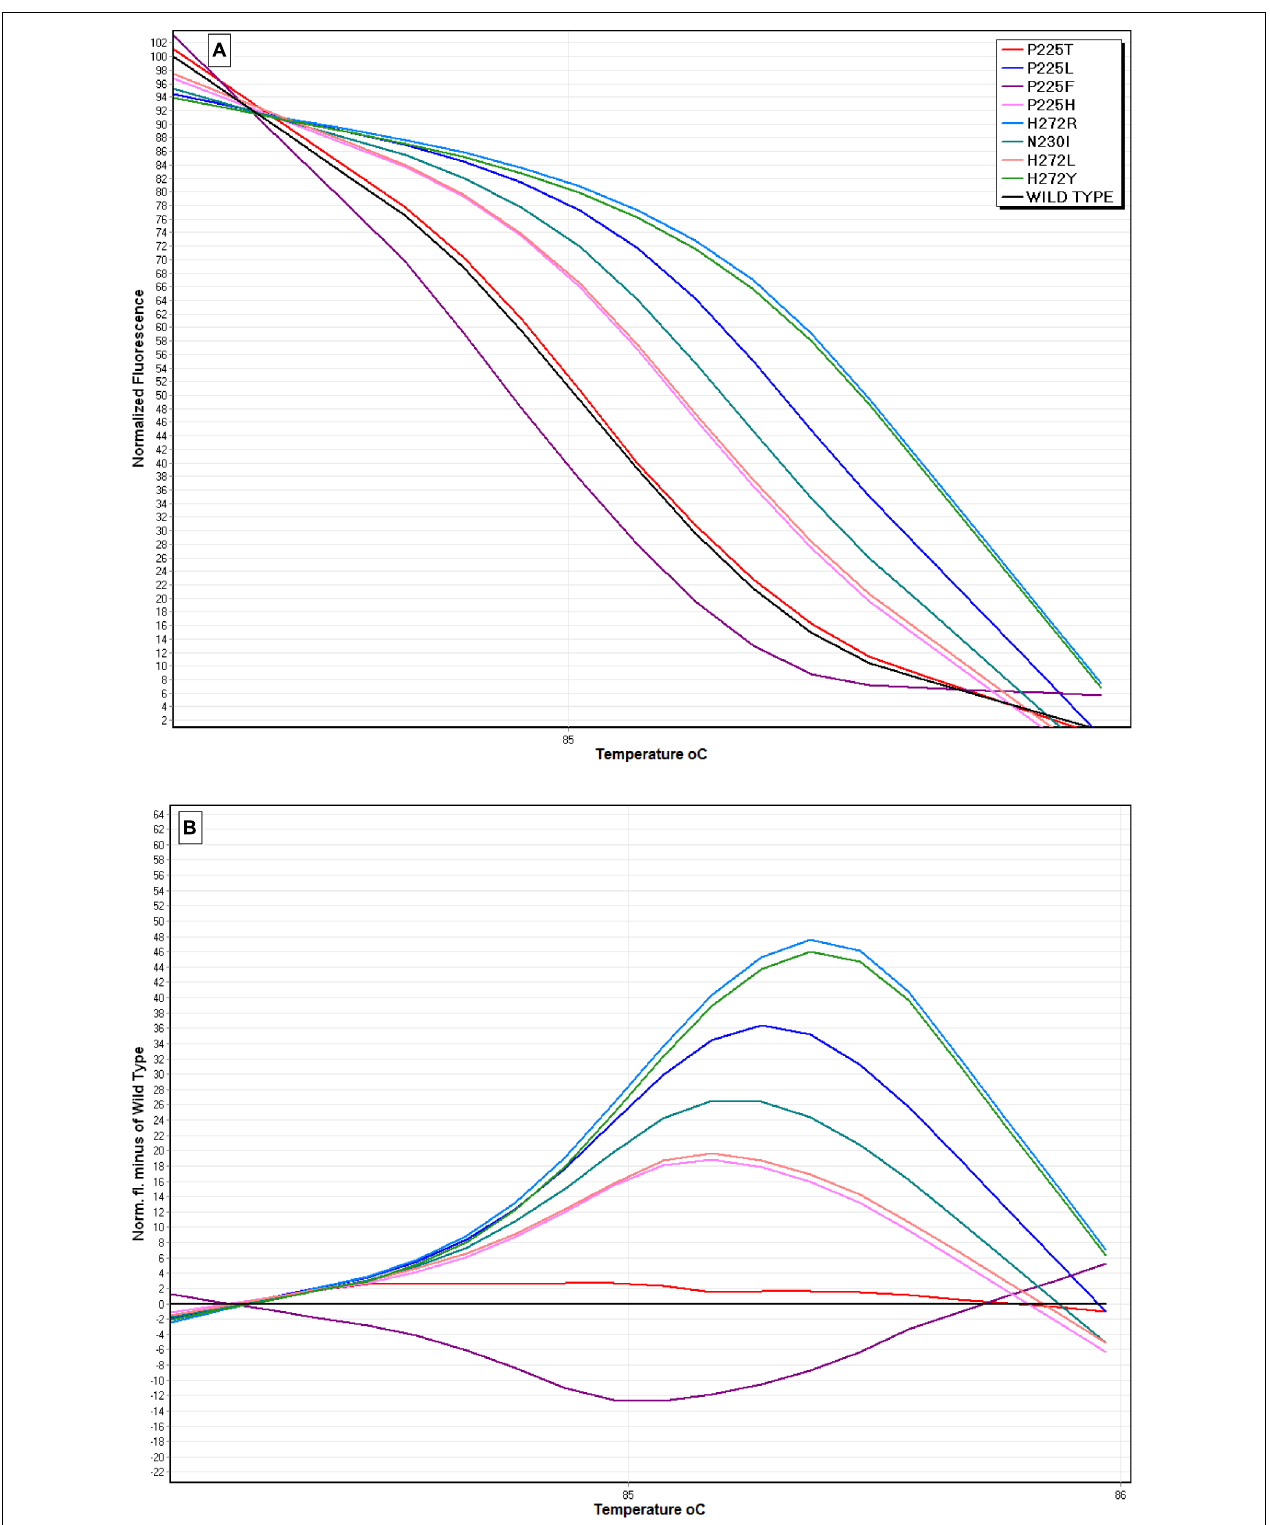
FIGURE 2 | High resolution melting (HRM) analysis using the primers SDHB-Fw and SDHB-Rev for the discrimination of SDHI-resistant B. cinerea isolates possessing the sdh B mutations P225H/T/F/L, H272R/Y/L, and N230I. (A) Normalized HRM curves of isolates with different mutations, (B) Difference curves of HRM using a sensitive isolate as the reference baseline